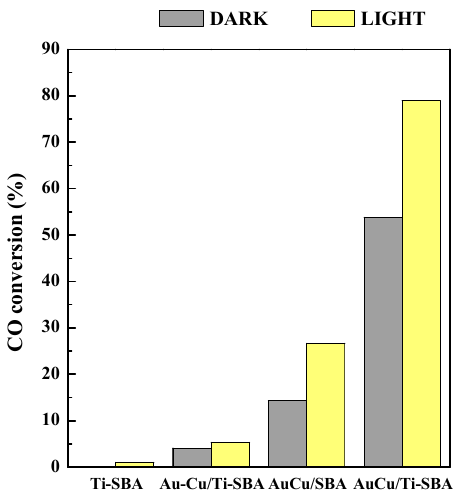
Figure 11. Conversion for the CO preferential oxidation in excess of hydrogen in dark and simulated solar light irradiation.